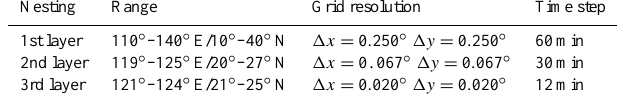
Table 1. Simulated regions, grid resolutions, and time steps of model nestings.